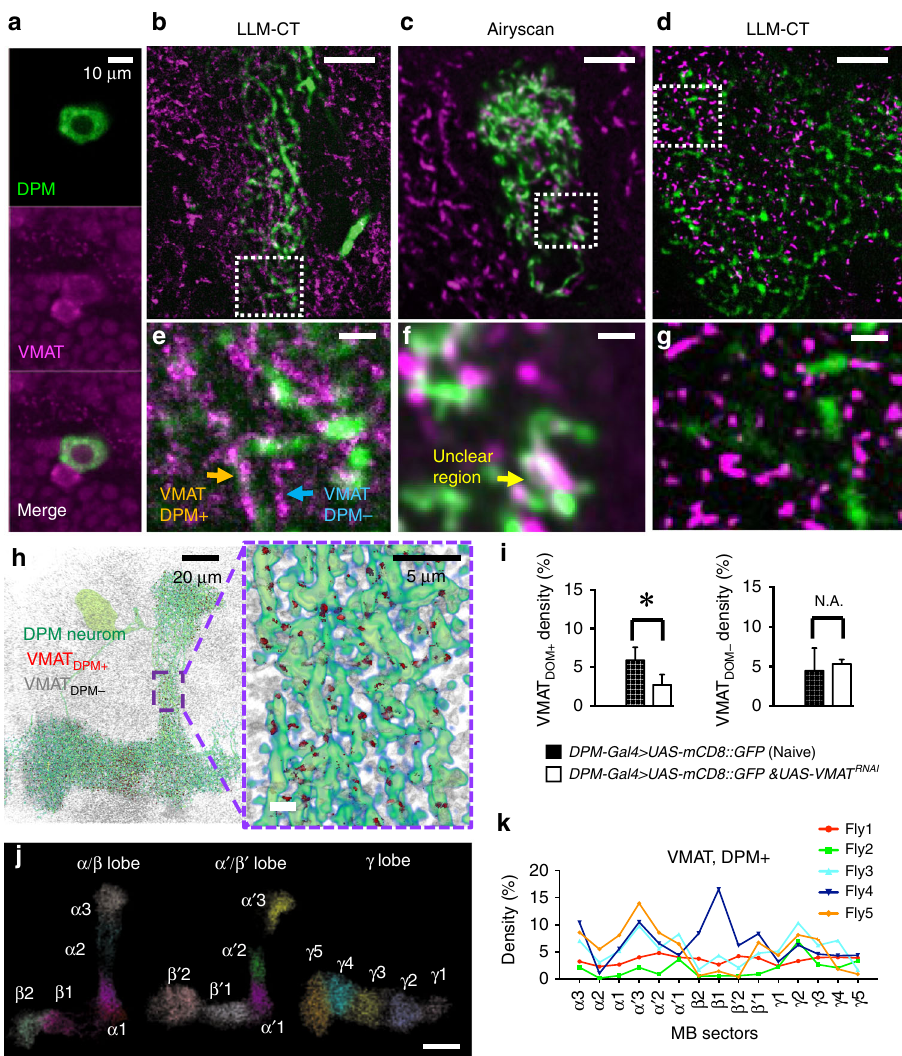
Fig. 6 Co-localization between VMAT molecules and DPM neurites in the whole MB. a VMAT signal in the soma taken by Zeiss 880 confocal microscopy. b LLM-CT showed distinguishable signal of anti-VMAT immuno-positive molecules (magenta) were within or outside the DPM neurites (green). c As a comparison, Airyscan super-resolution confocal microscopy provides relatively poorer resolution. The ambiguous overlapping signals prevent the high accuracy co-localization analysis. d Levels of anti-VMAT immuno-positive molecules decreased within but not outside the DPM neuron in the fl ies carrying UAS-mCD8::GFP ; VT64246-Gal4 / UAS-VMAT-RNAi transgenes. e – g Magni fi ed views of the images in the white boxes of ( b – d ). VMAT was immunolabeled with Alexa Fluor 635 ( a , c , f ) or HMSiR ( b , d , e , g ). h Visualization of VMAT molecules. Left, VMAT proteins (gray) distributed within (red) or outside (gray) the DPM neurons (green). Right, an enlarged view. i VMAT RNAi -mediated changes in VMAT density in the DPM + neurites (left) but not in DPM- regions (right) within the MB. Each value represents mean ± S.E.M. ( n = 3). * P < 0.05. j A representative volume image showing the 3D distribution of VMAT in the DPM neurites innervating MB lobes: α / β ( α 1, α 2, α 3, β 1, β 2), α ′ / β ′ ( α ′ 1, α ′ 2, α ′ 3, β ′ 1, β ′ 2) and γ ( γ 1 − γ 5). Color code indicates VMAT DPM + signals in different MB sectors. k Comparison of VMAT distribution in the different MB sectors within the DPM neurites across 5 fl ies. Scale bar = 5 μ m in ( b – d ), 1 μ m in ( e – g ) and 20 μ m in ( j ) unless otherwise indicated. Source data are provided as a Source Data fi new proteins during long-term memory formation 36,37 . We super-resolution confocal microscopy (Fig. 6c, f). To determine the imaging number of frames needed to map VMAT proteins hypothesized that VMAT in a DPM neuron might be distributed (Supplementary Fig. 10; Supplementary Note 2), we determined differentially to modulate functional differences among MB sectors. theoretical resolution and localization density as discussed in Fig. 3. Accordingly, we manually segmented DPM neurites into 15 MB The reliability of DPM + VMAT localization was validated by targeting VMAT RNAi expression to DPM neurons, which reduced the pattern of input innervations from dopaminergic neurons the total number of VMAT molecules in DPM + neurites but not in (Supplementary Fig. 11; Methods). With quantitative single- DPM- regions of MB lobes (Fig. 6d, g, i; Methods). molecule localization by LLM-CT, we found that VMAT proteins DPM neurites completely engulf both the vertical and horizontal distribute unevenly within a DPM neuron and their density in each lobes (axonal outputs) of the MBs 33 but activity in the vertical lobes MB sector is highly variable among different fl ies (Fig. 6j, k). The appears to sub serve behavioral responses after a few sessions of plasticity of VMAT distribution we observe here may account for olfactory classical conditioning 34 . Furthermore, MB output neurons the translation of transient MB activity into long-term memory exhibit learning-gene dependent tuning plasticity 35 and synthesize coding at the MB outputs neurons.